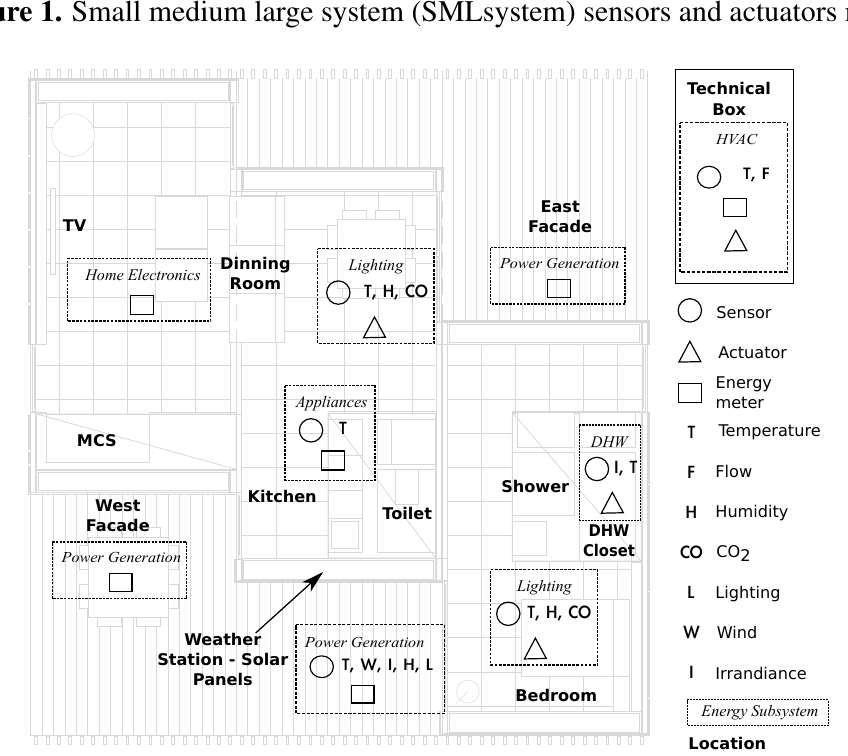
Figure 1. Small medium large system (SMLsystem) sensors and actuators